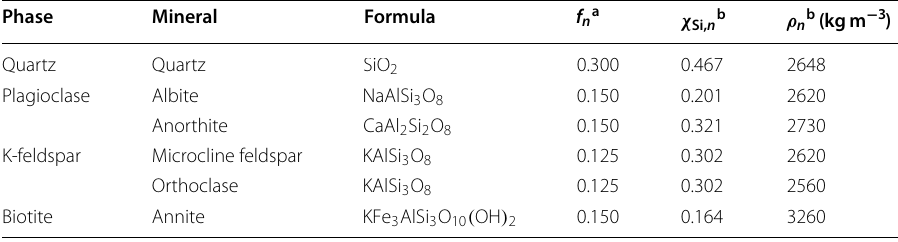
Mineral composition considered for the calculation of fracture aperture changes, due to chemical mineral dissolution, where f n is the mineral volume fraction of the n -th mineral, χ Si, n is the mass fraction of Si per mol of mineral n , and ρ n is the density of mineral n a Grimsel granodiorite: ∼ 30% quartz, ∼ 30% plagioclase, ∼ 25% K-feldspar, ∼ 15% biotite, and minor amounts of white mica and chlorite (Stalder 1964; Schaltegger 1989)